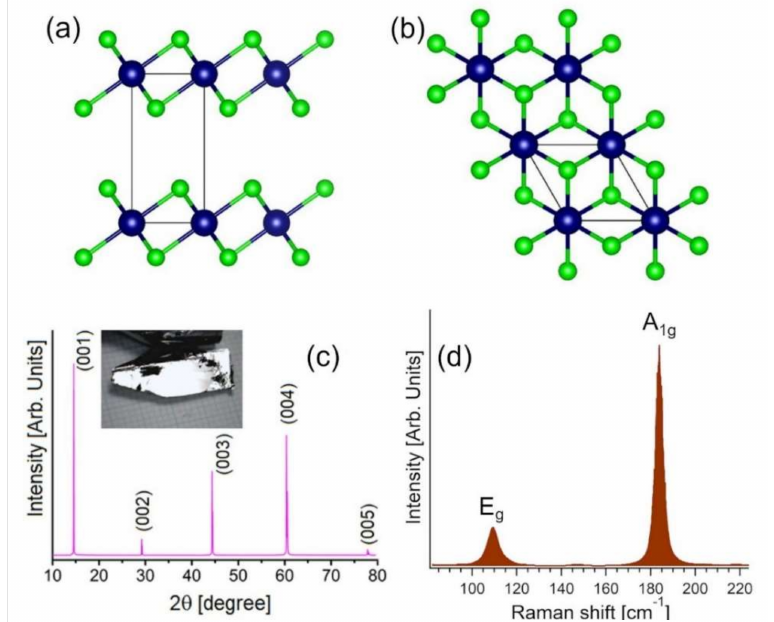
Figure 1. ( a ) Side and ( b ) top views of the atomic structure of SnSe 2 . Green and blue balls denote Se and Sn atoms, respectively. Panel ( c ) reports the single-crystal XRD pattern from the (001) plane of SnSe 2 . The inset shows a photograph of an as-grown SnSe 2 single crystal. Panel ( d ) reports the Raman spectrum of SnSe 2 single crystal acquired at room temperature with a laser with wavelength λ = 632.8